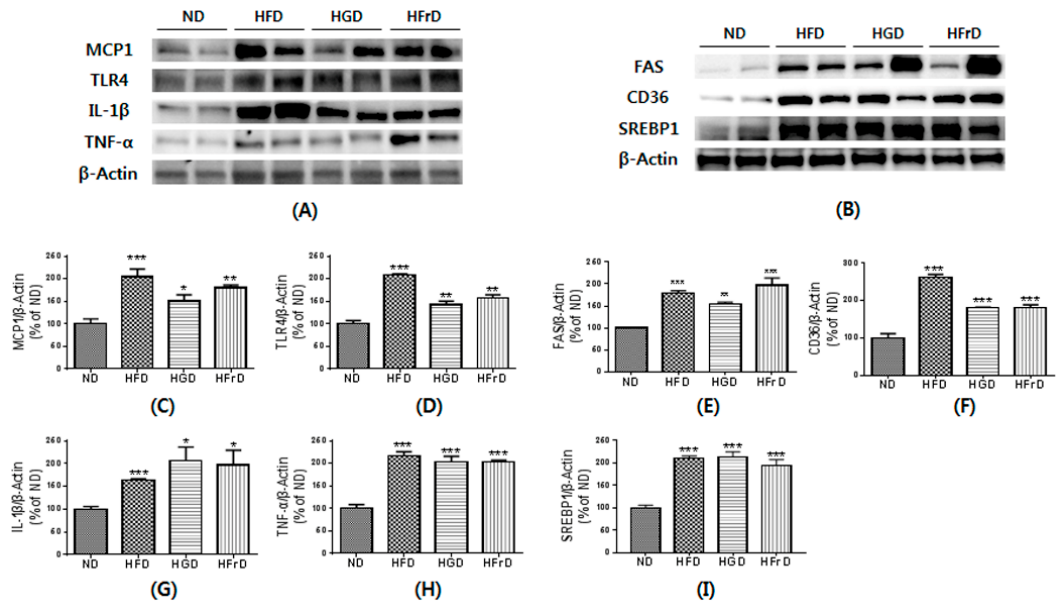
Figure 5. HFD, HGD or HFrD-induced hepatic inflammation and change of lipid metabolism. ( A , B ) representative images of Western blots for inflammatory cytokines (MCP1, TLR4, IL-1 β and TNF- α ) and lipid metabolism (FAS, CD36 and SREBP1); ( C – I ) relative band intensities of MCP1 ( C ), TLR4 ( D ), IL-1 β ( E ), TNF- α ( F ), FAS ( G ), CD36 ( H ) and SREBP1 ( I ) normalized to those of β -actin. Bar values are presented as mean percentage of ND ± SEM of three independent experiments (* p < 0.05, ** p < 0.01, and *** p < 0.001 vs. ND).